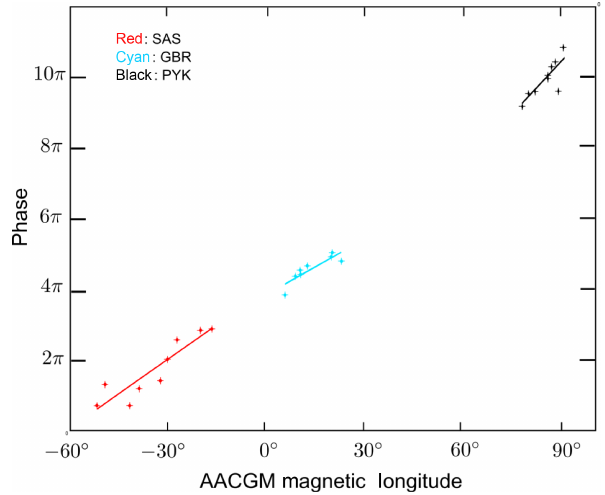
Figure 10. Event 1. Consolidated plot of phase as a function of AACGM latitude across the fields of view of the Saskatoon, Goose Bay and Þykkvibær